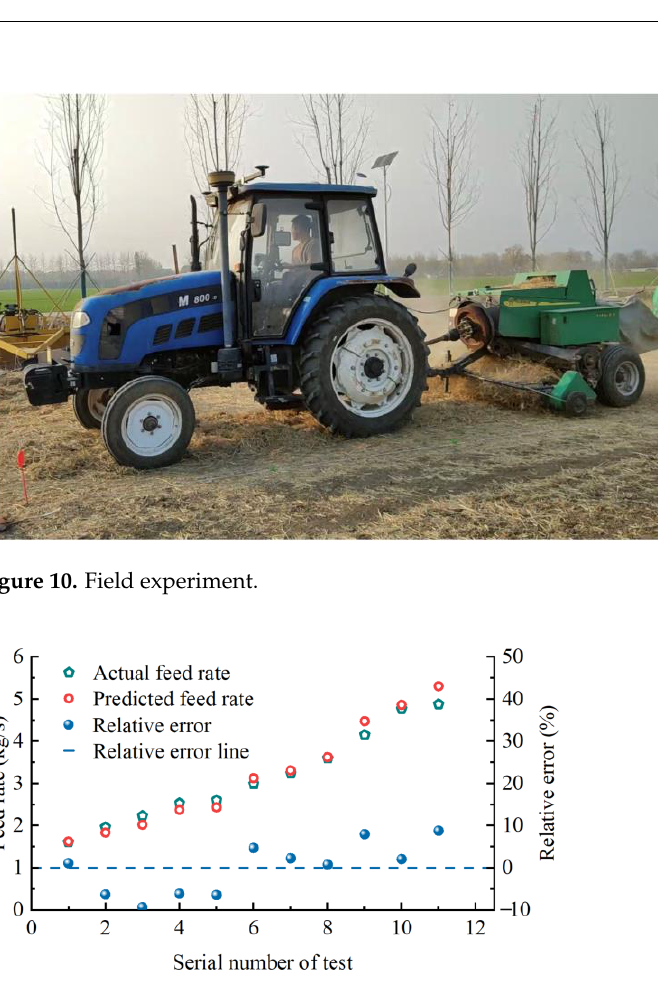
Figure 11. Field test results.